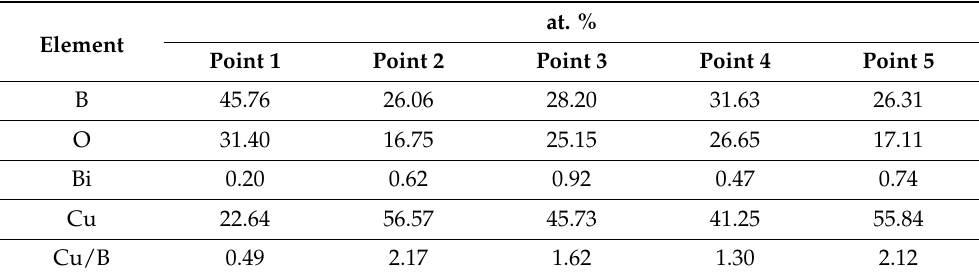
Table 1. Results of EDS analysis at the points marked in Figure 3d for 30% CuB 2 O 4 –70% Cu 3 B 2 O 6 ceramic doped with 5% CuBi 2 O 4 , sintered at 900 ◦